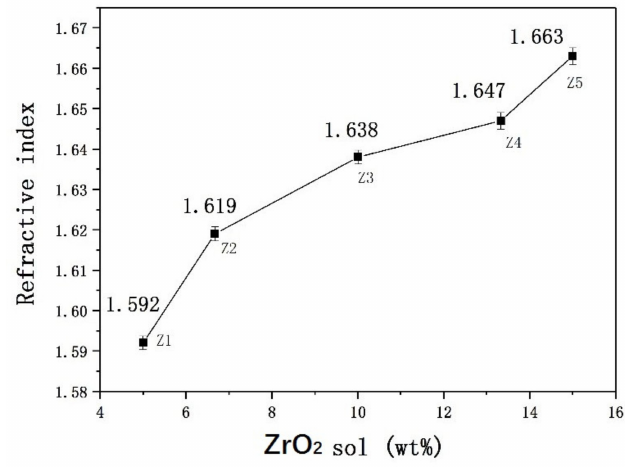
Figure 8. Refractive index changes of composite coatings with di ff erent ZrO 2 sol content.